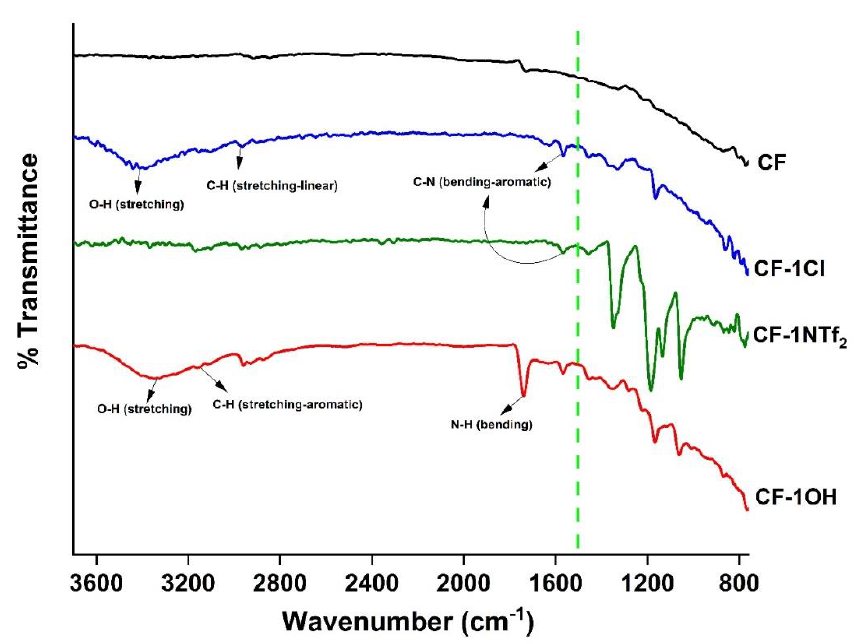
Figure 5. FTIR-ATR transmittance spectra for the studied CF Figure 5 . FTIR-ATR transmittance spectra for the studied CF samples.